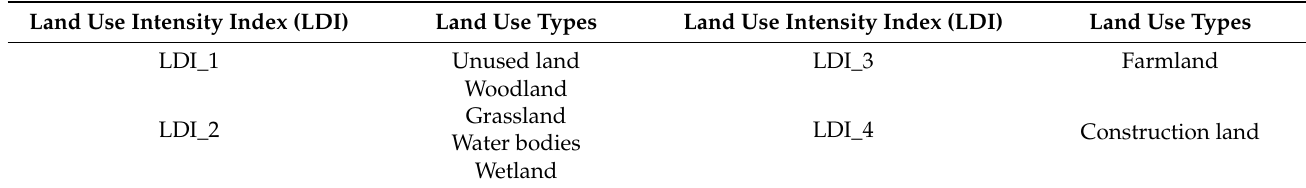
Table 1. Land use intensity division in the study